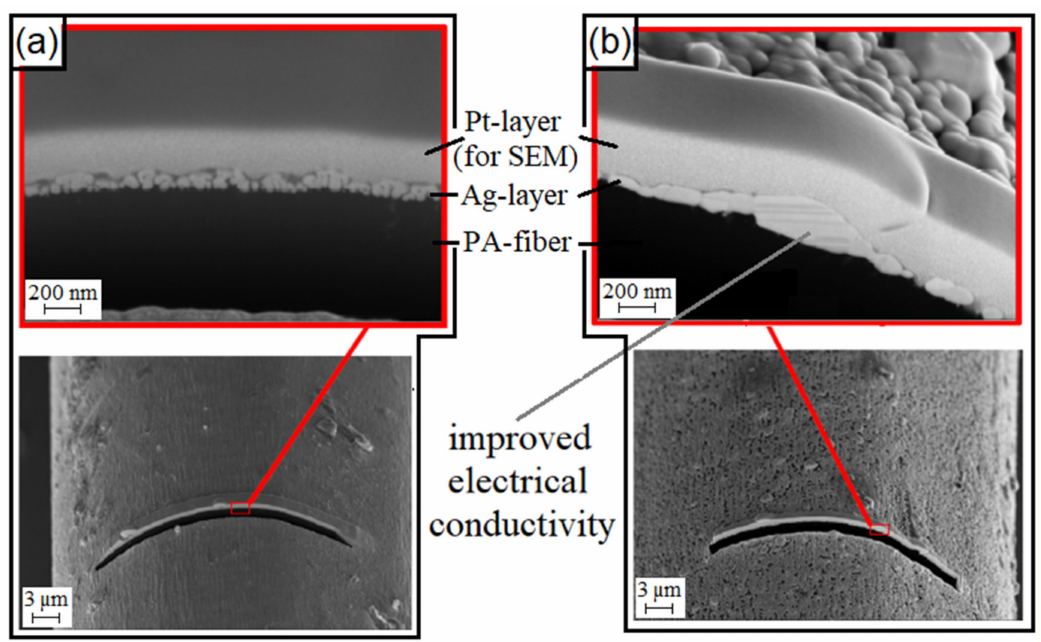
Figure 4. SEM-image of a cut with a focused ion beam (FIB) on a thermally: ( a ) untreated; ( b ) tempered silver-plated PA 6.6